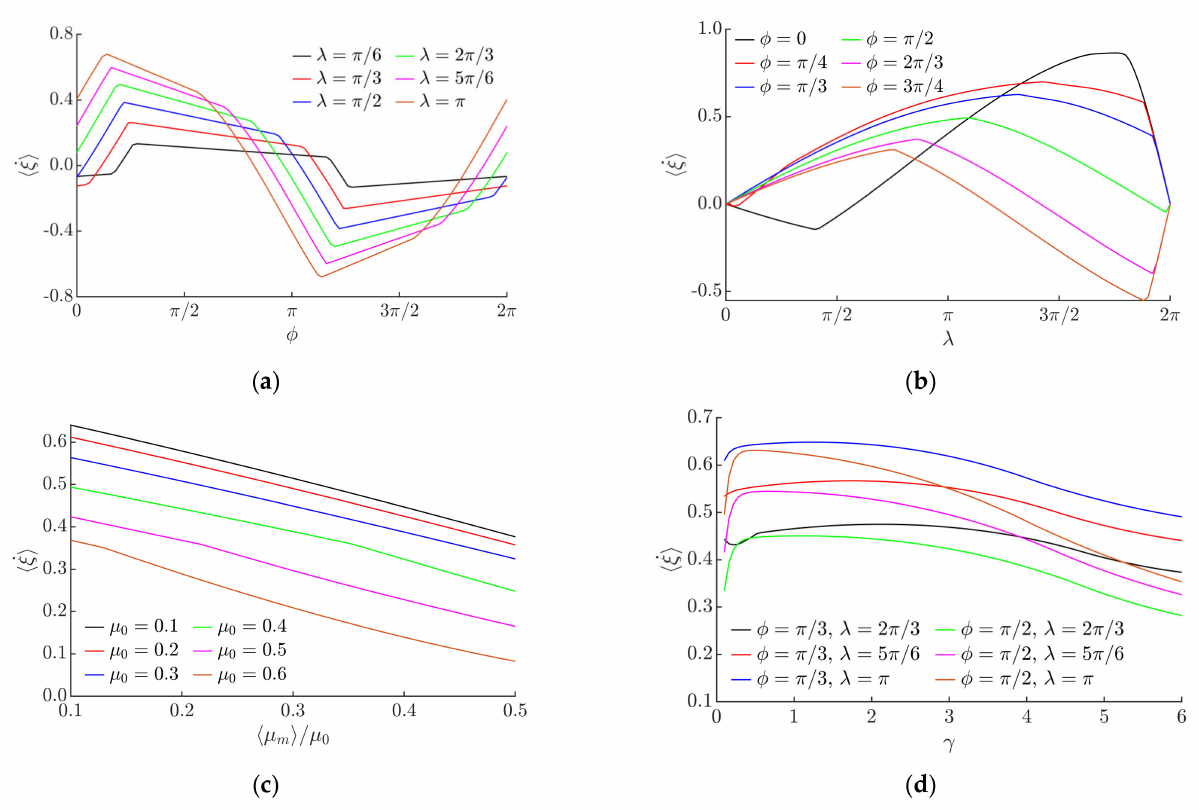
Figure 6. Non-dimensional average velocity depending on: ( a ) phase shift φ when γ = 4, µ 0 = 0.1, 〈 µ m 〉 / µ 0 = 0.125; ( b ) λ when γ = 4; µ 0 = 0.1, 〈 µ m 〉 / µ 0 = 0.125; ( c ) 〈 µ m 〉 / µ 0 when γ = 1, φ = π /2, λ = π ; ( d ) γ when µ 0 = 0.1, 〈 µ m 〉 / µ 0 =